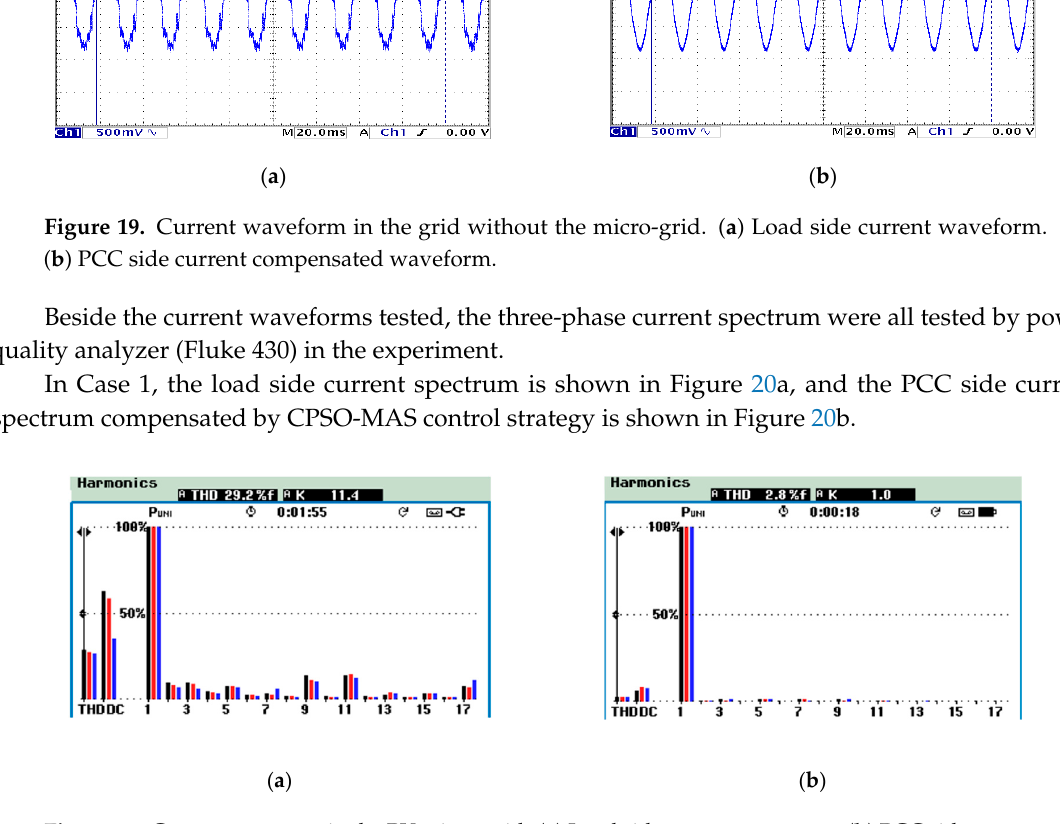
Figure 20. Current spectrum in the PV micro-grid. ( a ) Load side current spectrum. ( b ) PCC side current compensated spectrum.